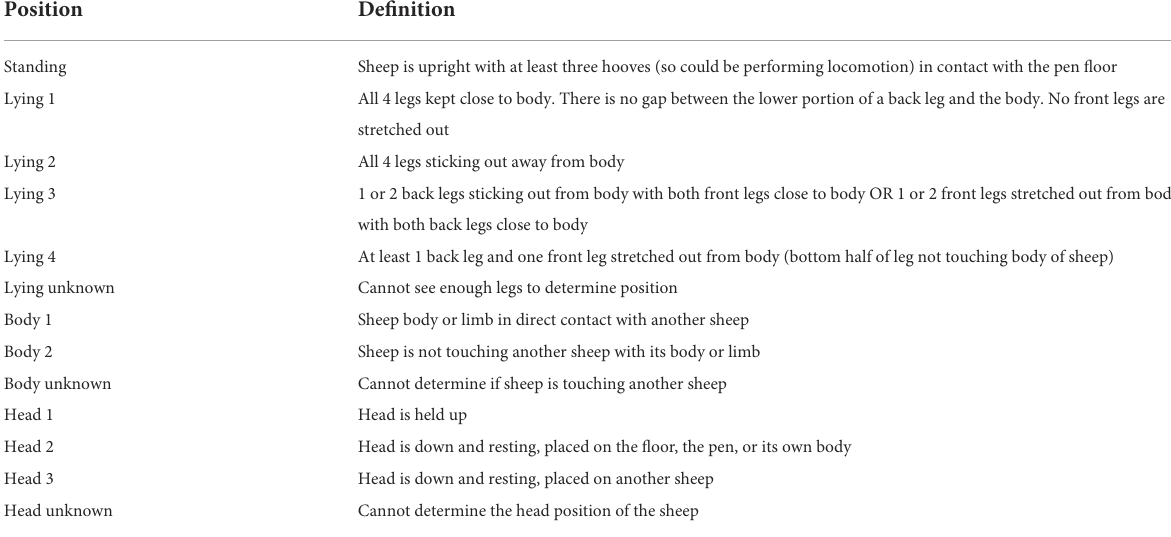
TABLE 3 Ethogram utilised to record positional behaviours for all the sheep at scan sampling observation